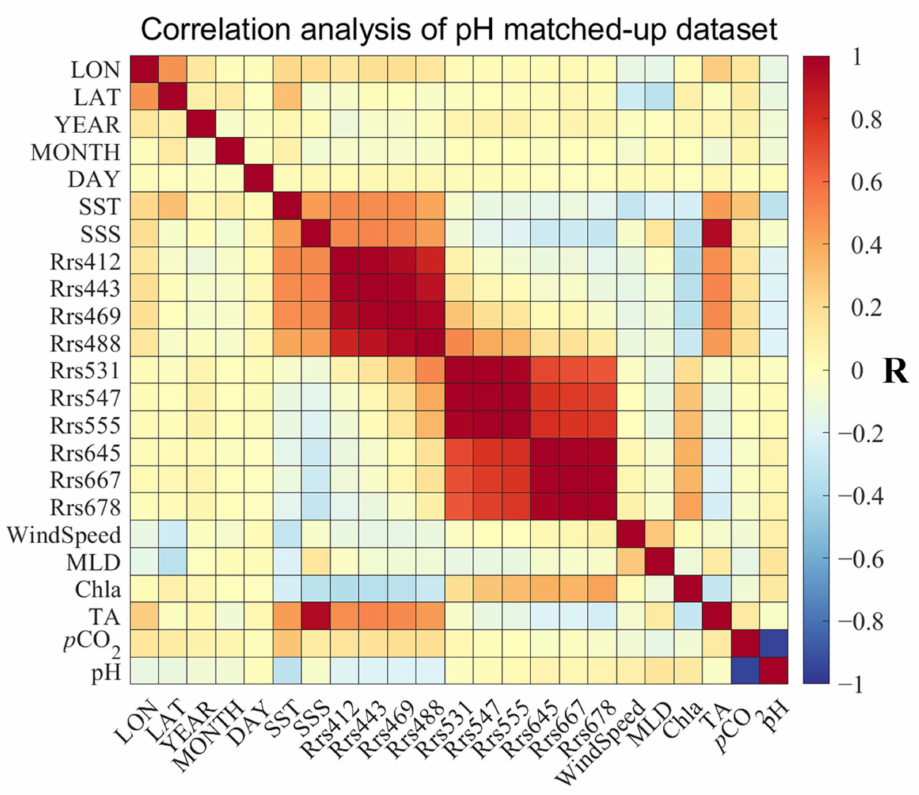
Figure 8. Correlation analysis matrix of pH underway dataset with related parameters. The R-values of the pH-related parameters in the matrix were all significant ( p -value less than